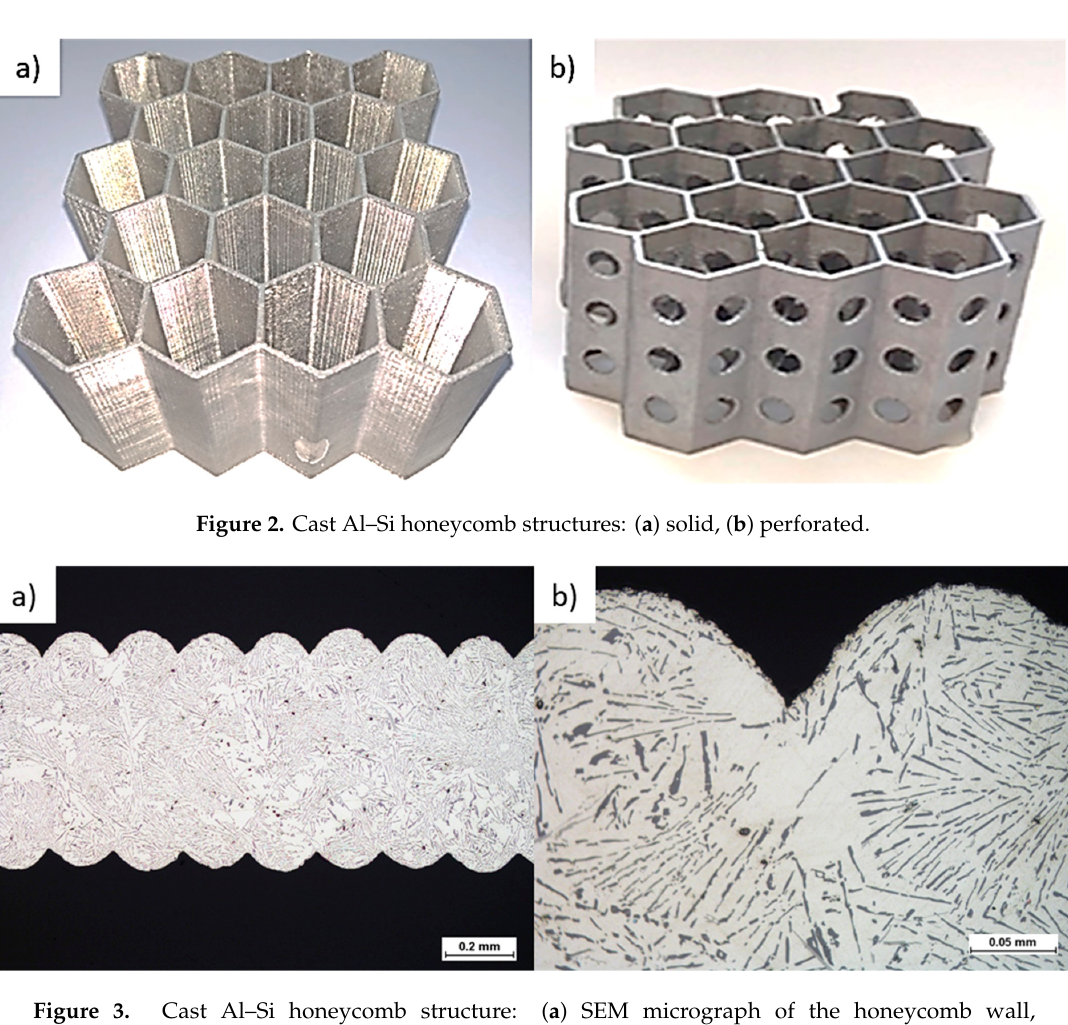
Figure 3. Cast Al–Si honeycomb structure: ( a ) SEM micrograph of the honeycomb wall, ( b ) microstructure.